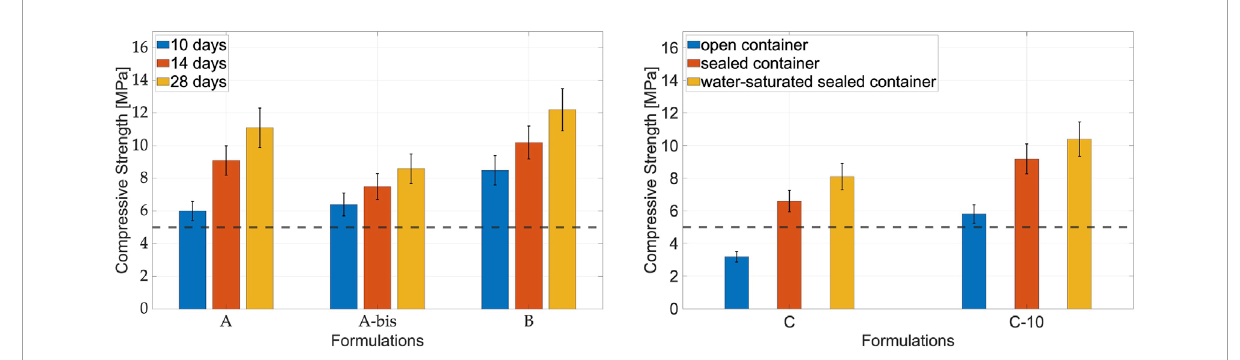
FIGURE 7 Compressive strength of the geopolymer formulations: (left) after 10, 14, and 28 days of in-mould curing; (right) after 10 days of curing in different conditions. The dotted line represents the minimum requirement imposed by the WAC for cement-based